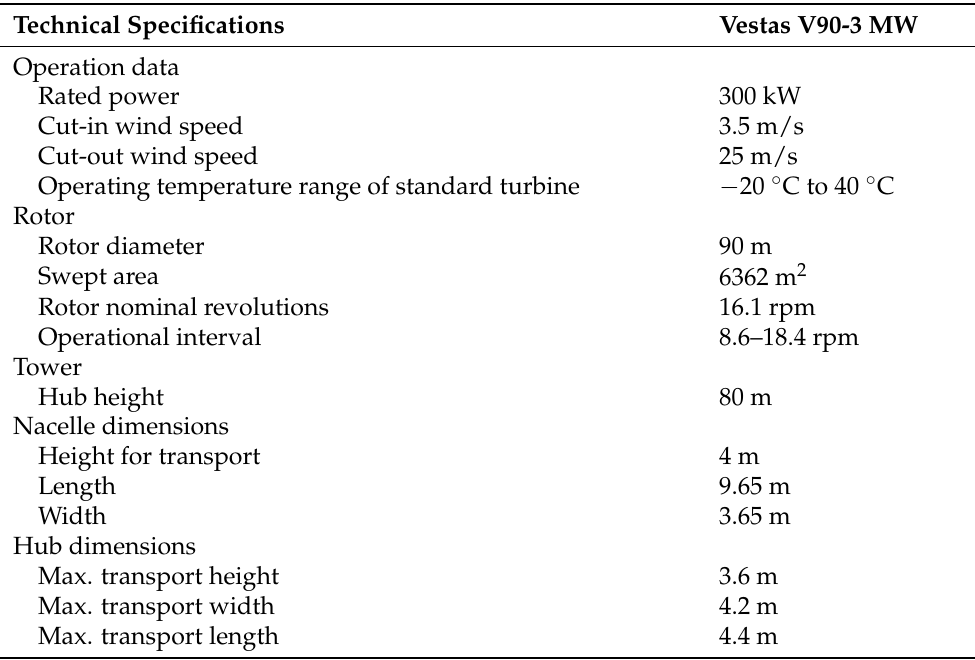
Table 2. The technical parameters of Vestas V90-3